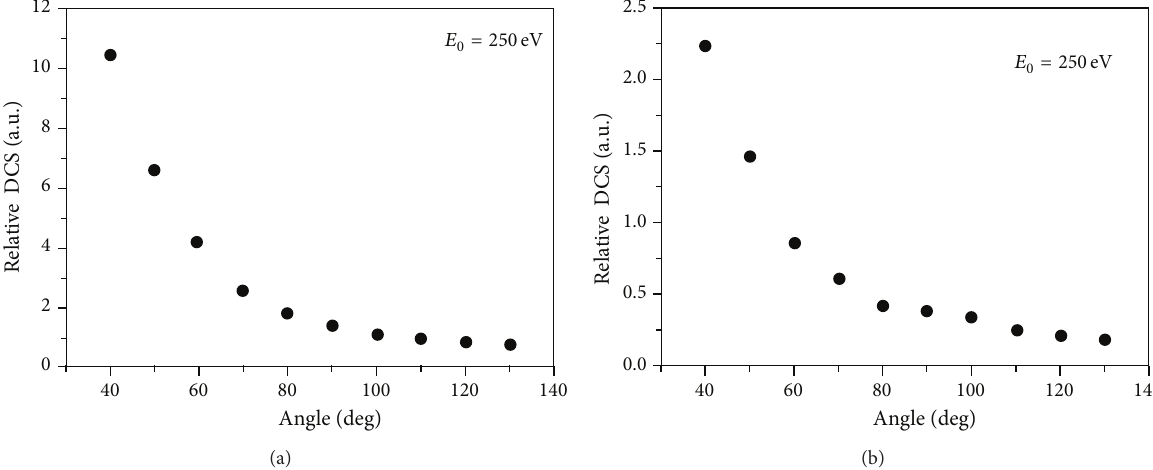
pass the outer hemisphere. The radii of inner and outer hemispheres are 𝑅 1 = 81.7 mm and 𝑅 1 = 112.5